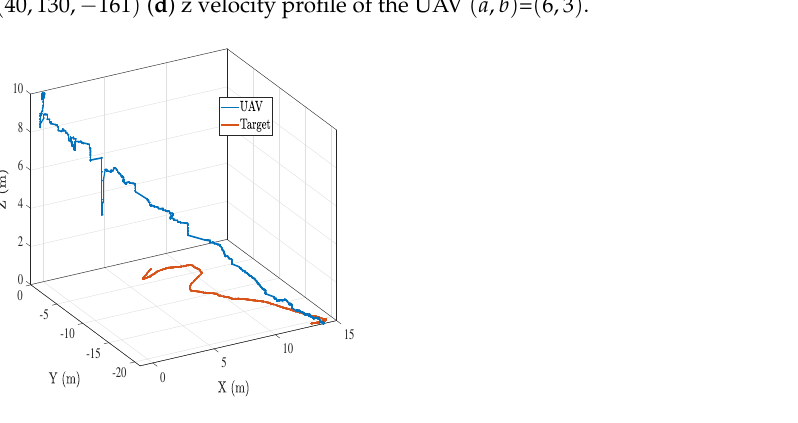
Figure 16. Case2: UAV-target trajectory for a nonstraight-line moving target